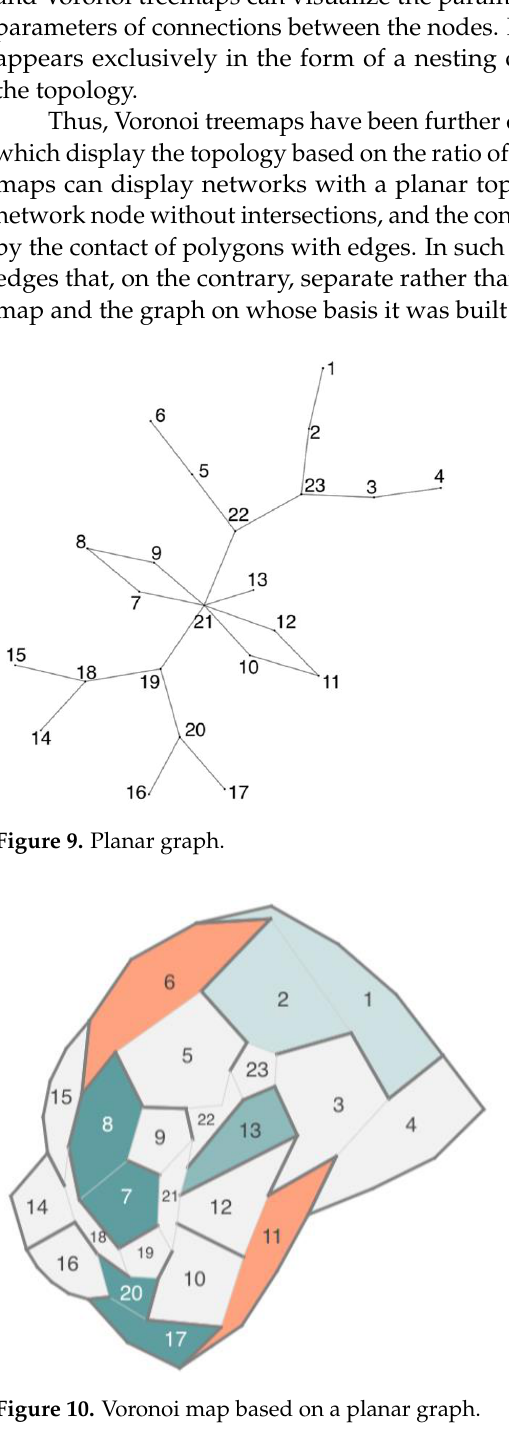
Figure 10. Voronoi map based on a planar graph.